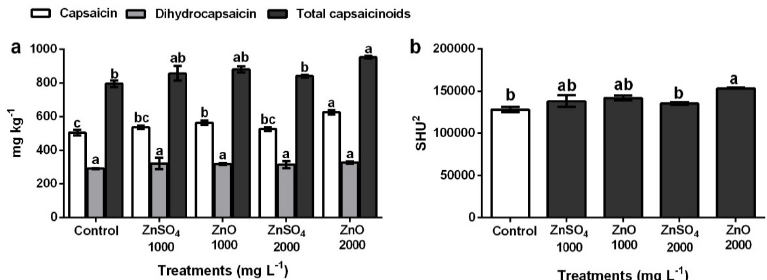
Figure 3. Capsaicinoids content in habanero pepper fruits from plants treated with ZnO NPs and ZnSO 4 . ( a ) capsaicin, dihydrocapsaicin and total capsaicinoids, ( b ) Scoville Heat Units (SHU 2 ). Values